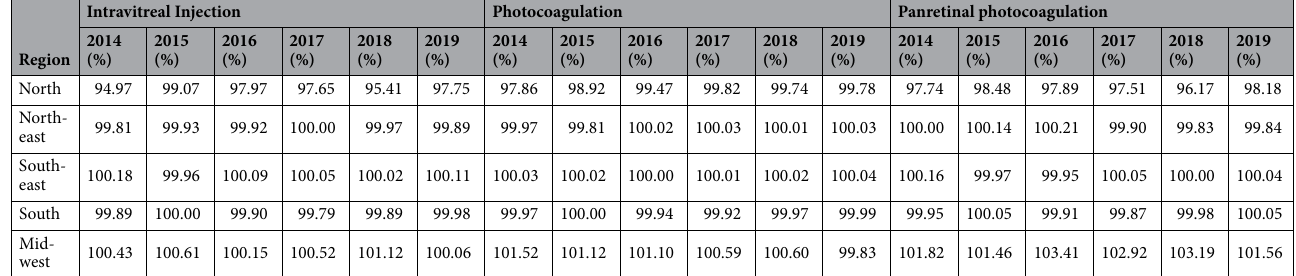
Table 3. Spatial treatment coverage for diabetic retinopathy according to year and type of